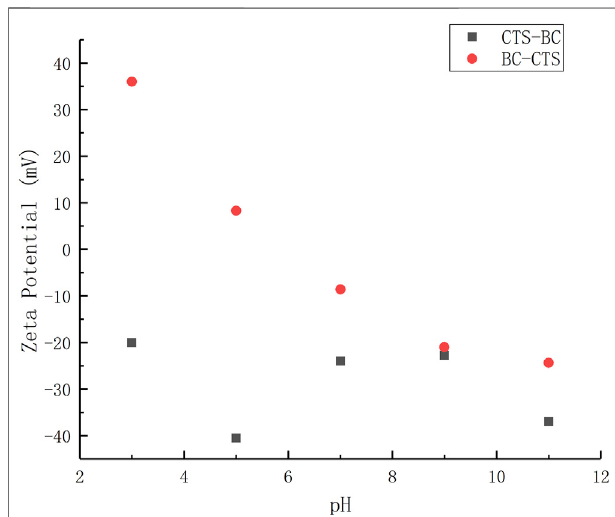
FIGURE 8 | Effect of solution pH on Zeta.